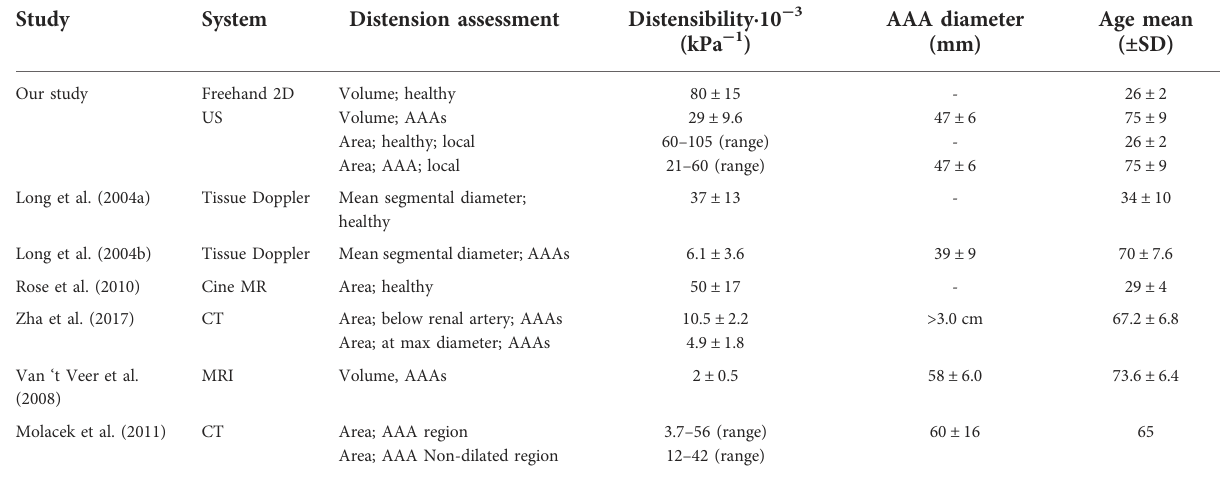
TABLE 5 Comparison of our distensibility fi ndings with other